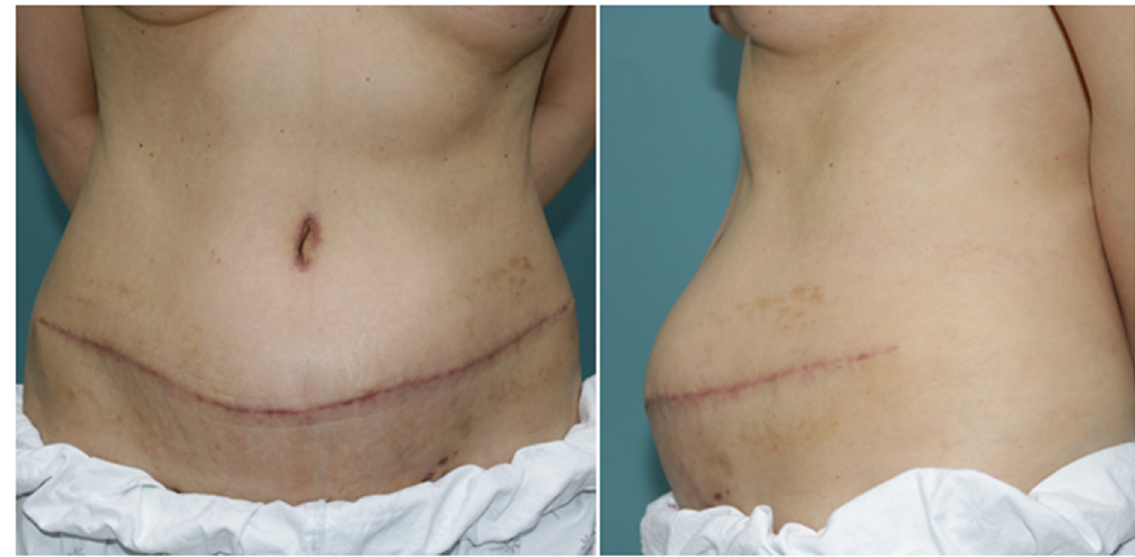
Figure 2. Clinical image of a 50-year-old female patient taken 6 months after delayed breast recon- struction with a pedicled TRAM flap. Direct closure was performed on the donor's fascial defect. A distinct bulging at the site of the fascial defect was found during a physical examination.